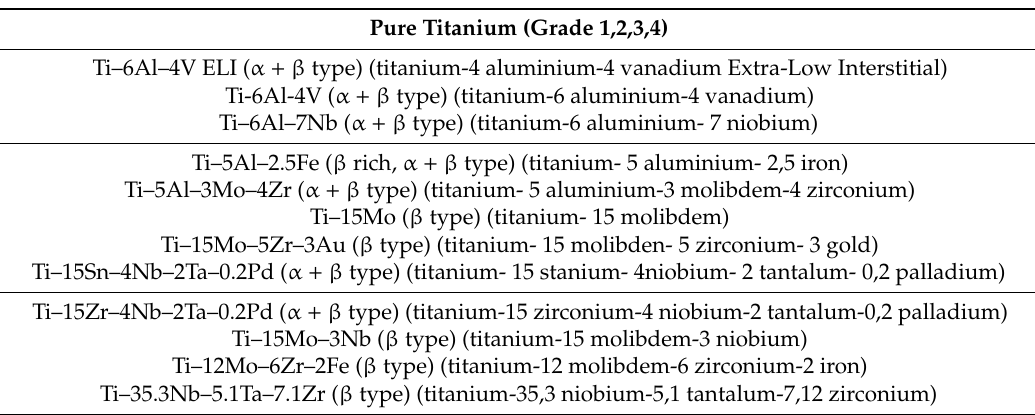
Table 2. Titanium alloys used in medical